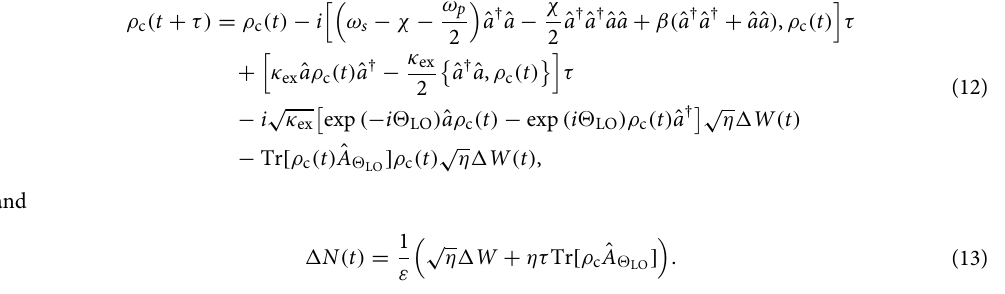
Figure 7. ( a ) T U K and T L K as a function of respectively. The black and red data are for K fixed, in order to change as in Fig.